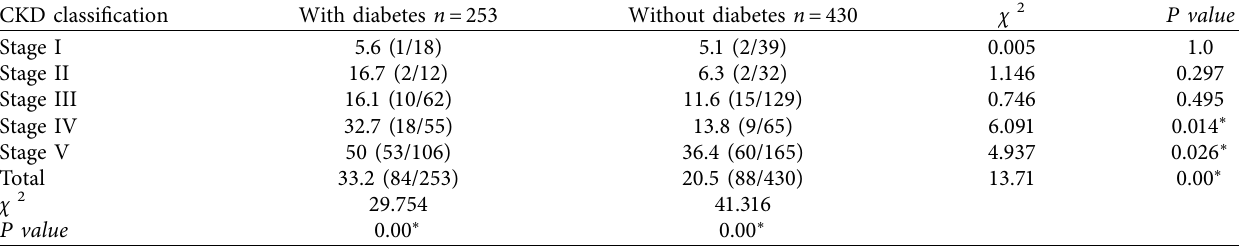
Table 2: Prevalence of nutritional risk (NRS ≥ 3 points) in CKD patients with or without diabetes in different stages ( n (%)). CKD classification